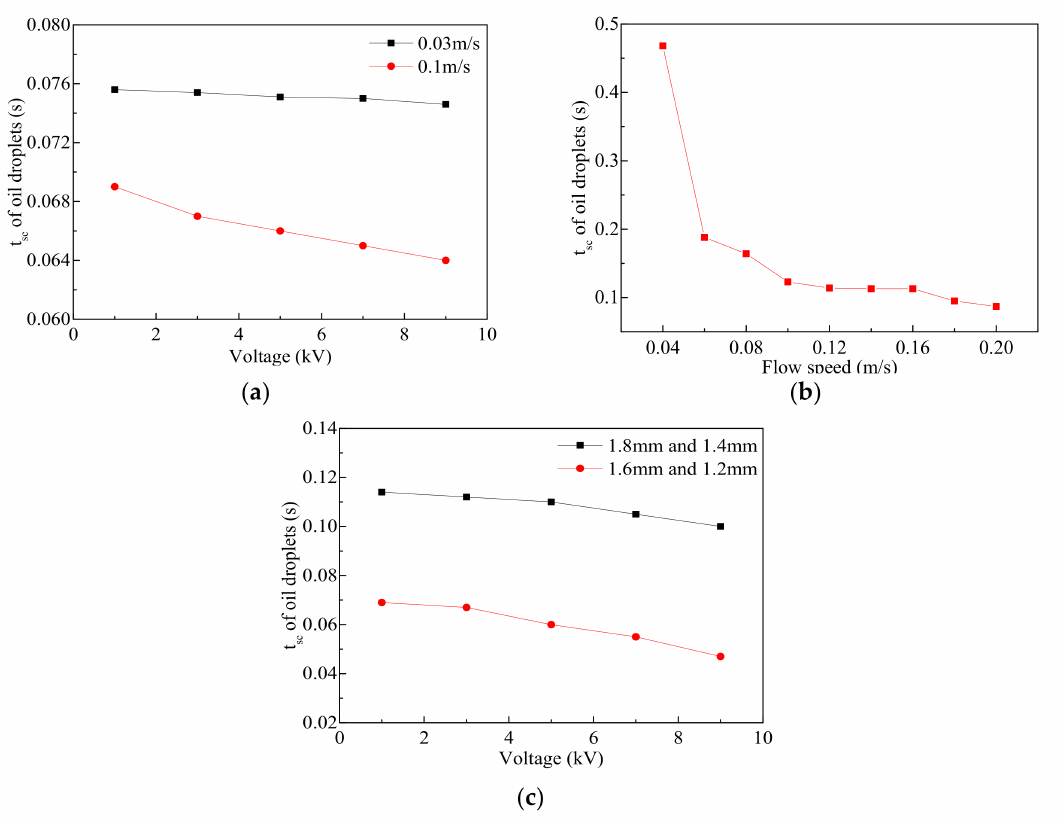
Figure 8. Influence of various factors on coalescence effect. ( a ) Voltage, ( b ) flow speed, ( c )